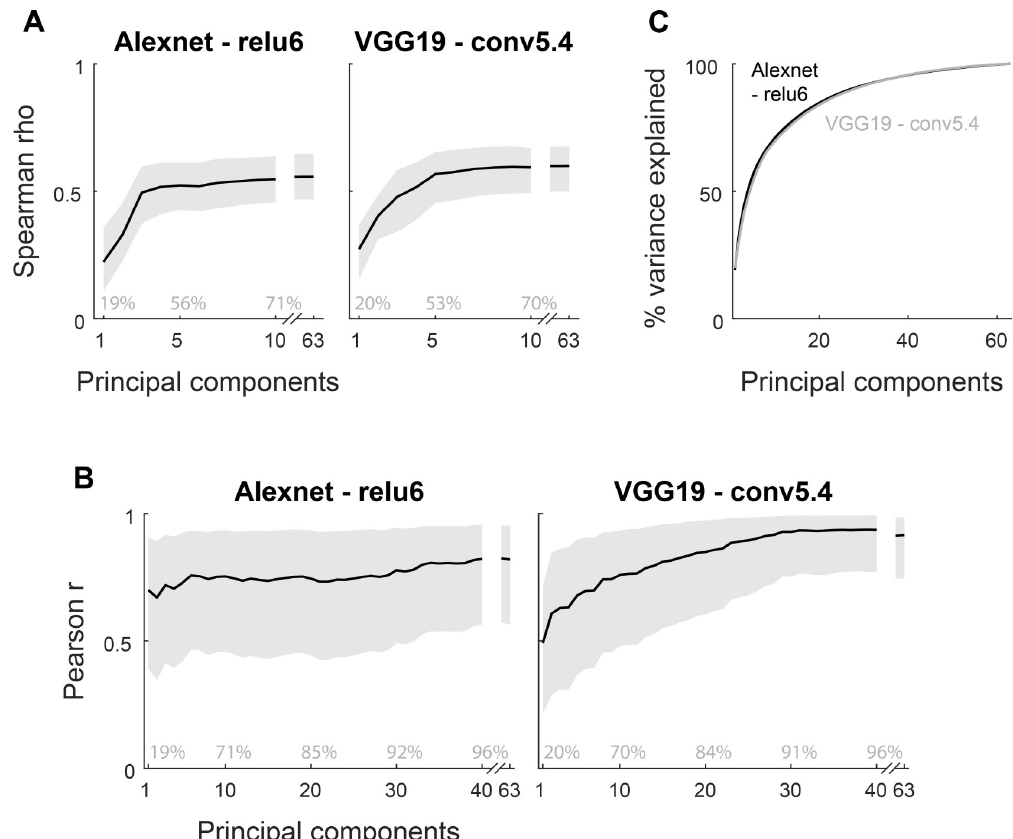
Fig 7. Similarities between IT and CNN peak layer shape dissimilarities as a function of retained principal components. (A) Spearman rank correlation coefficients between IT and peak CNN layer similarities are shown for each of two CNN models as a function of retained principal components of the CNN layer activations. The dissimilarities were Euclidean distances. Error bands depict 95% confidence intervals, determined by 10,000 bootstrap samples of the IT neuronal pool. (B) The cumulative proportion of explained variance as a function of principal component number for the Alexnet (black line) and VGG-19 layer (gray line). (C) Pearson correlation coefficients between the mean neural distances and the mean distances of the peak CNN layer (n = 6 mean distances; see Fig 10) as a function of retained principal components. In A and C, the bands represent 95% confidence intervals, determined by 10,000 bootstrap samples of the IT neuronal